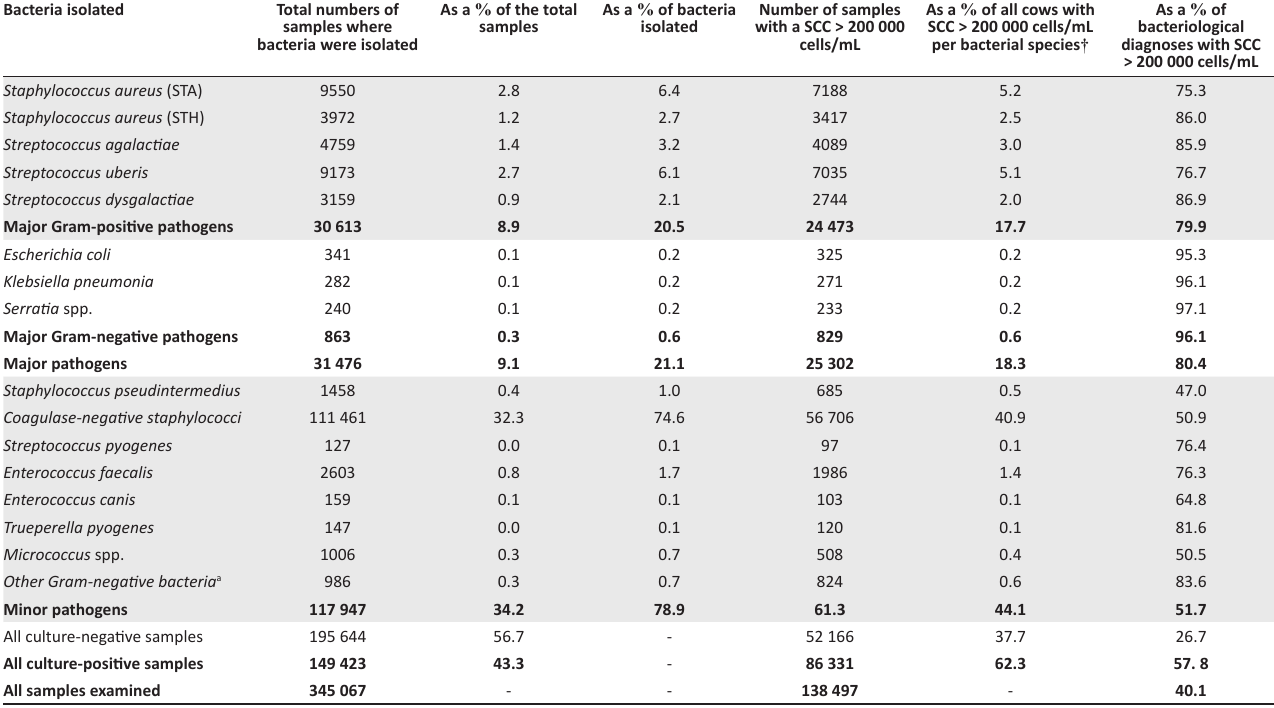
TABLE 4: Composite milk samples either negative or positive for bacteria indicating individual pathogen-specific bacteria and groups isolated from samples with and without somatic cell counts above 200 000 cells/mL milk. Bacteria isolated Total numbers of samples